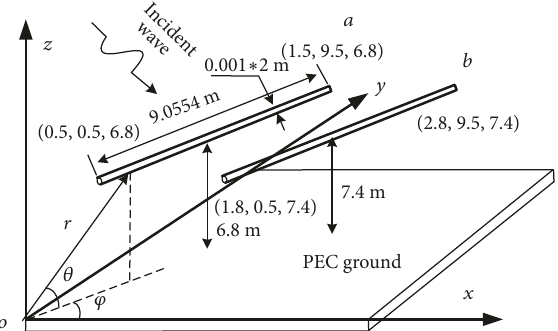
Figure 7: Two straight wires with a spacing of 1.42 m are placed parallel to the ground.